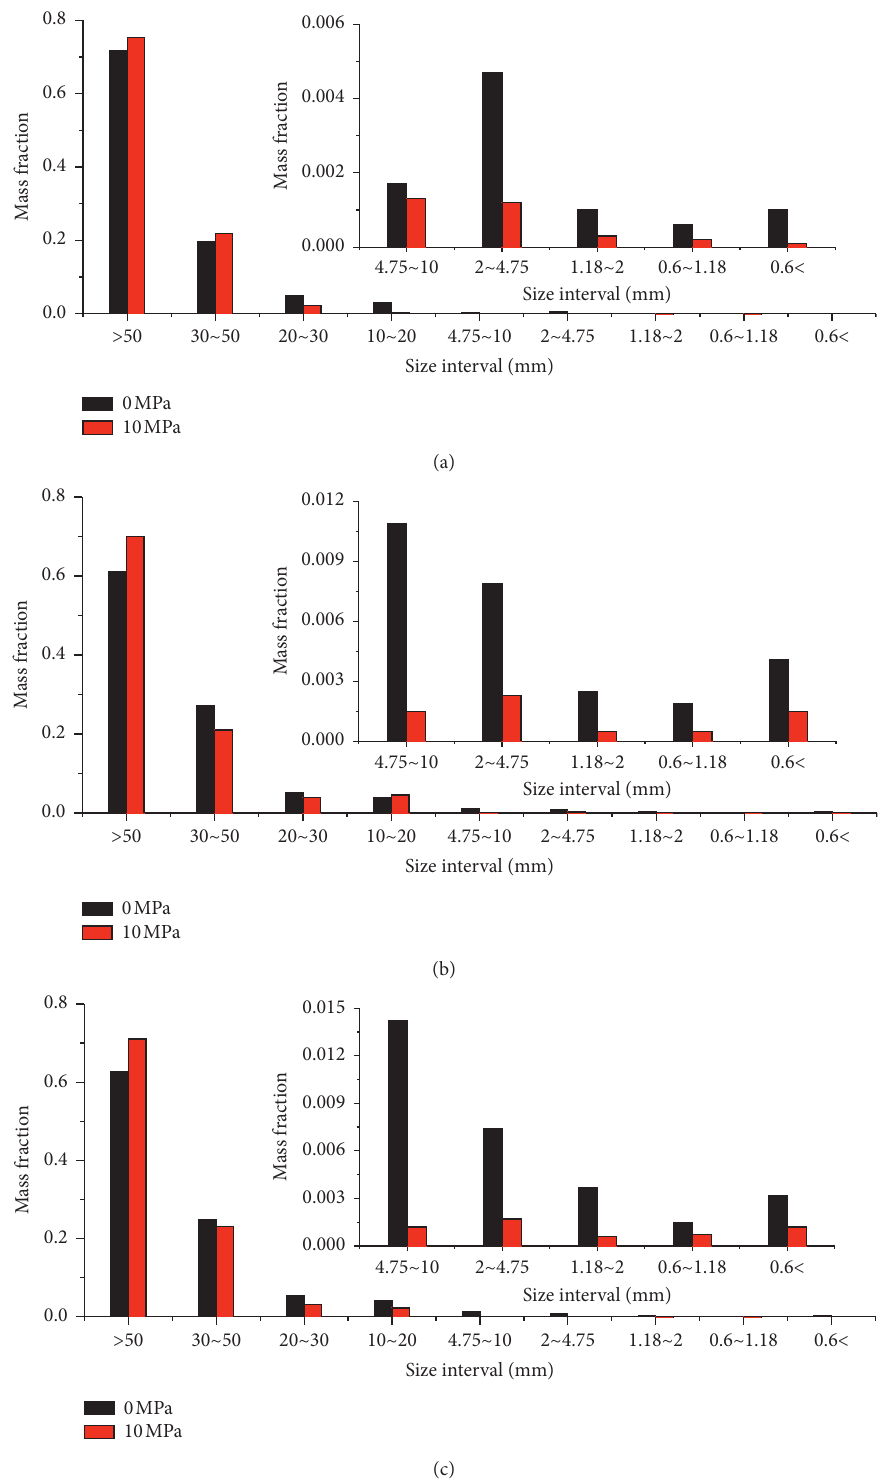
Figure 16: Mass fraction of limestone specimen fragments in different size intervals obtained under different test conditions. (a) Conventional compression test. (b) Cyclic loading test with a frequency of 0.25Hz. (c) Cyclic loading test with a frequency of 0.5